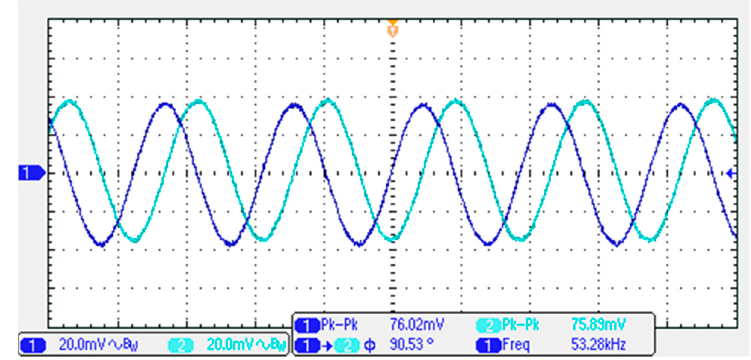
Figure 25. The experimental quadrature V o1 (blue) and V o2 (cyan) voltage waveforms.